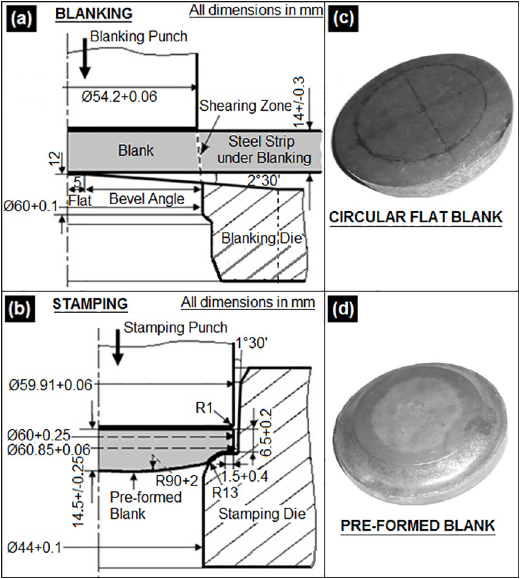
Figure 2. Schematically showing of arrangements, (a) blanking, and (c) stamping; Photo images, (b) circular flat blank, and (d) preformed